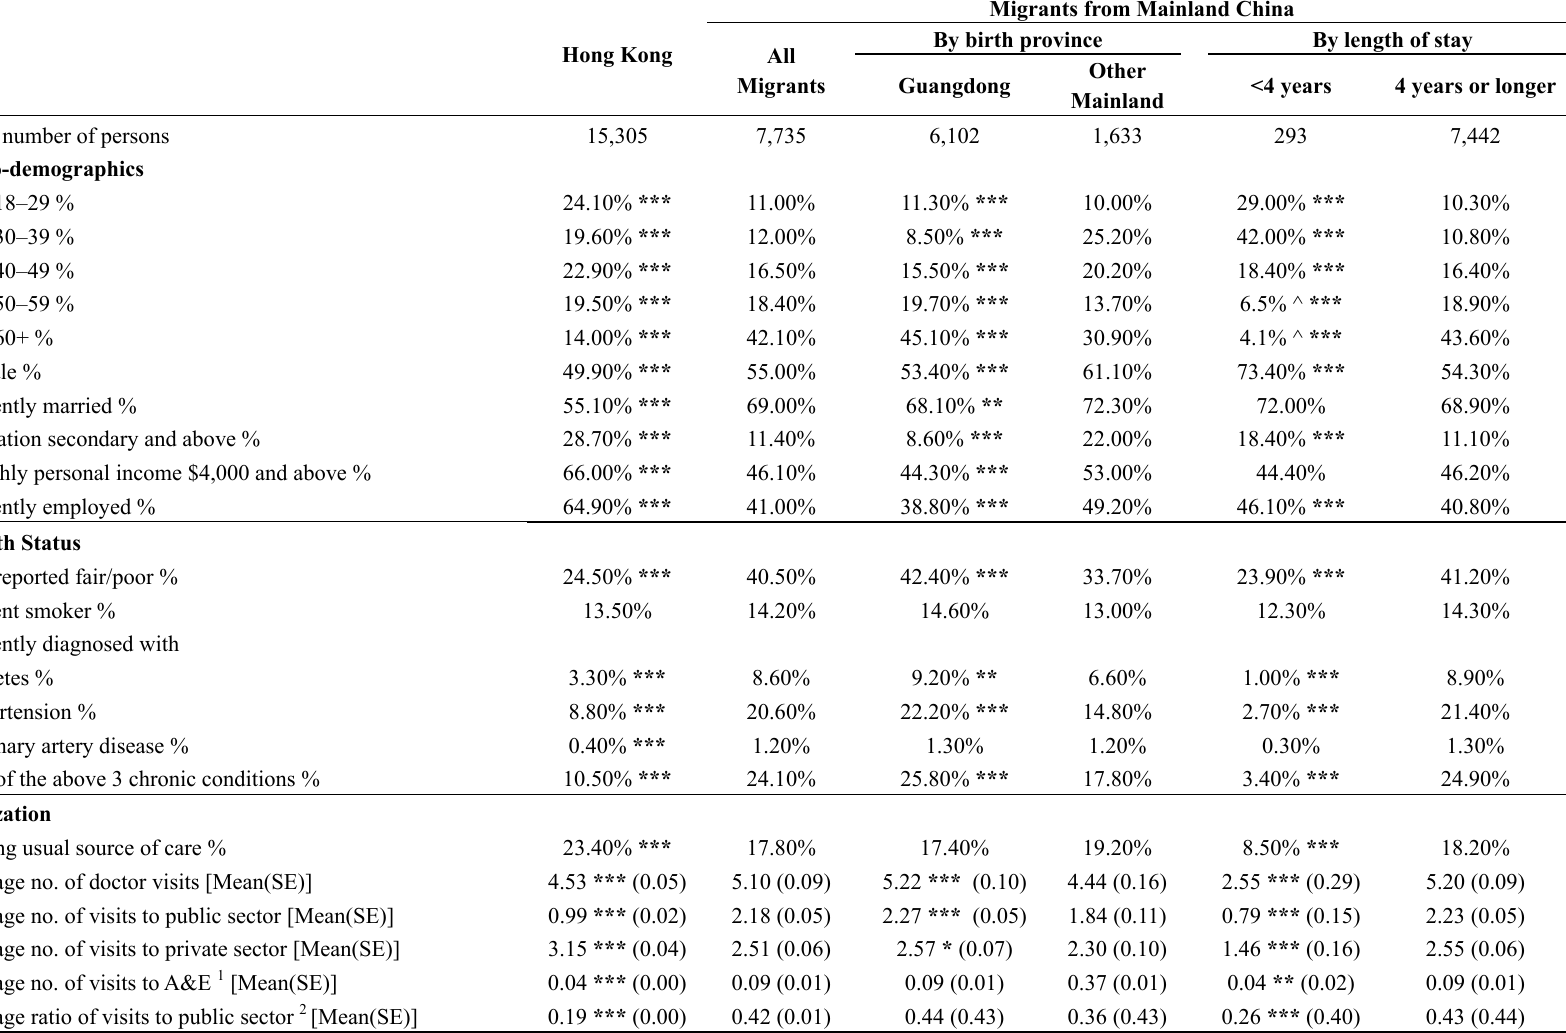
Table 1. Demographics and socioeconomic conditions among Hong Kong residents and mainland migrants. Migrants from Mainland Hong Kong